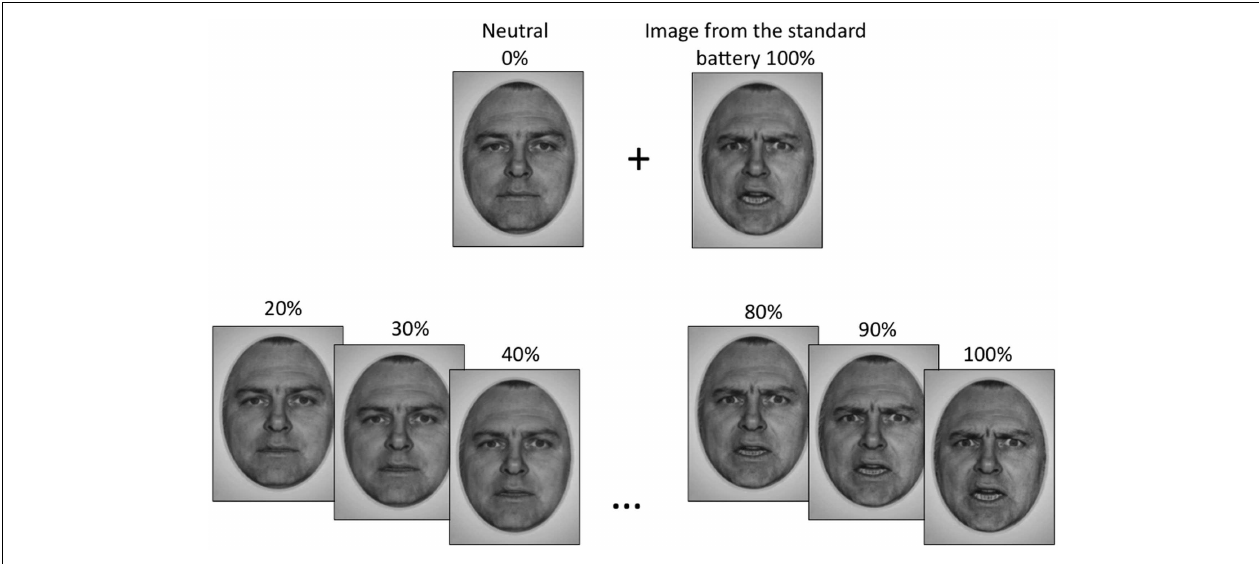
FIGURE 1 |The emotional face stimuli used in this study were generated by morphing a neutral face with an emotional image of the same actor from the standard face battery, to obtain gradations of